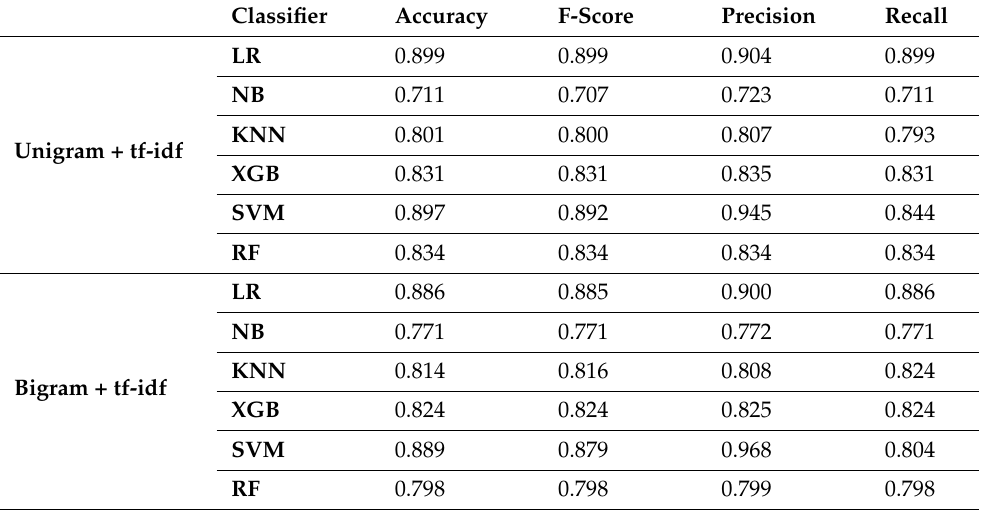
Table 6. Performance results from using TF-IDF extraction with different N-grams for all classification algorithms. Classifier Accuracy F-Score Precision